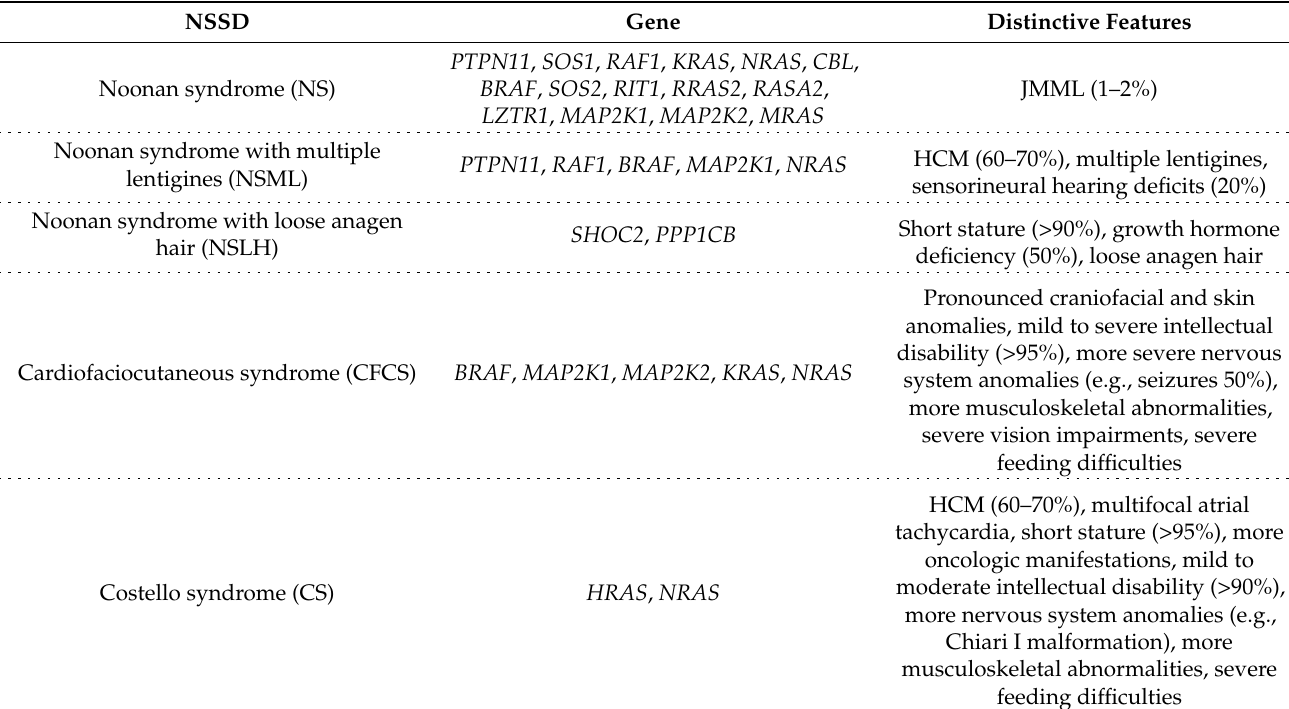
Table 1. Noonan syndrome spectrum disorders with their associated genes and distinctive